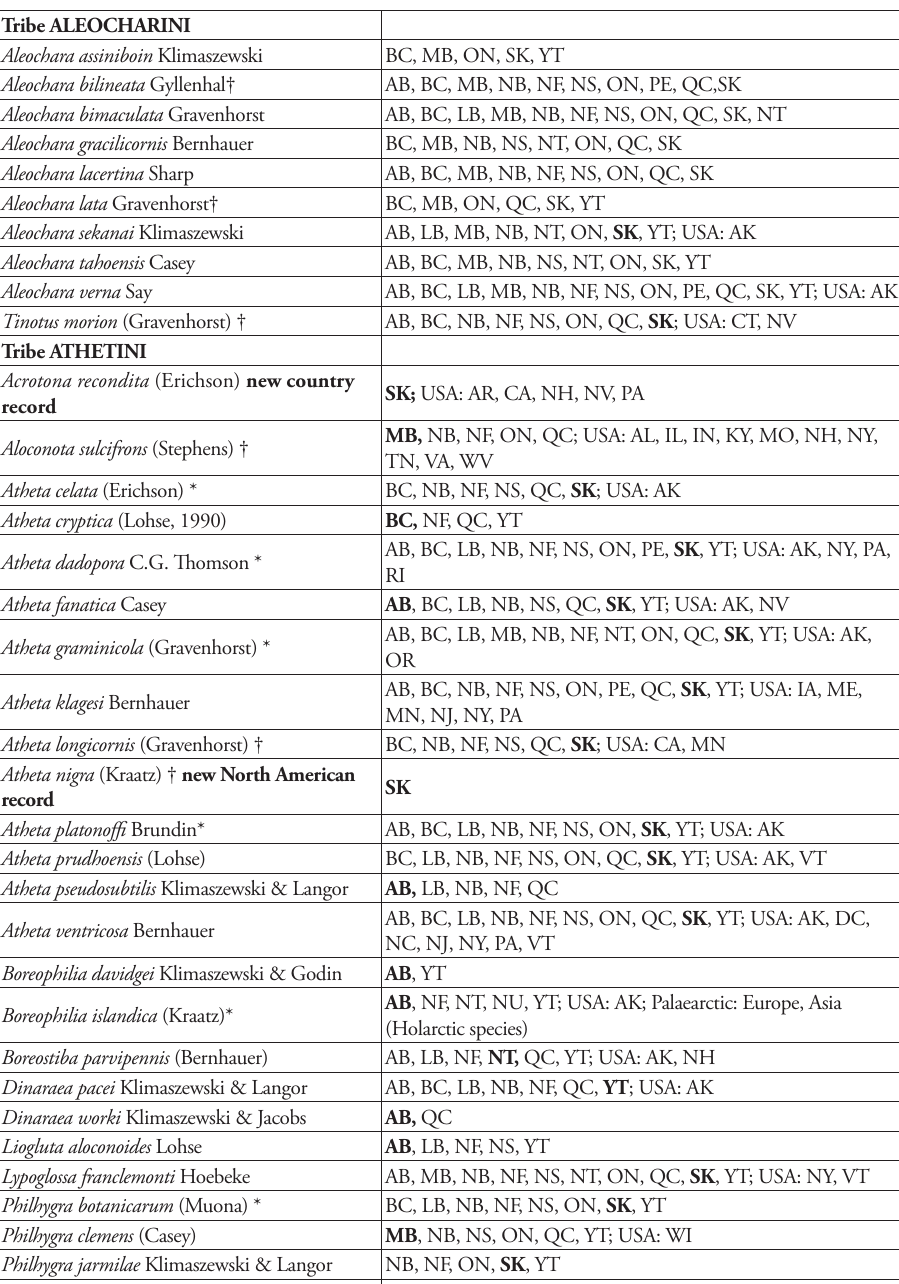
Table 1. Species of Aleocharinae recorded from SK and their provincial and territorial distribution within Canada and new records of species from AB, BC, MB and YT. Provinces and territories in bold denote new records given in the present publication. Species marked with (†) indicate adventive species and species marked with (*) are